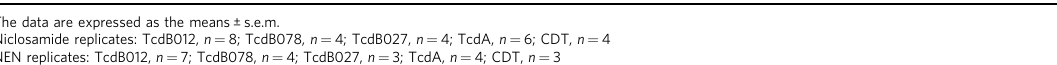
The data are expressed as the means±s.e.m. Niclosamide replicates: TcdB012, n = 8; TcdB078, n = 4; TcdB027, n = 4; TcdA, n = 6; CDT, n = 4 NEN replicates: TcdB012, n = 7; TcdB078, n = 4; TcdB027, n = 3; TcdA, n = 4; CDT, n =